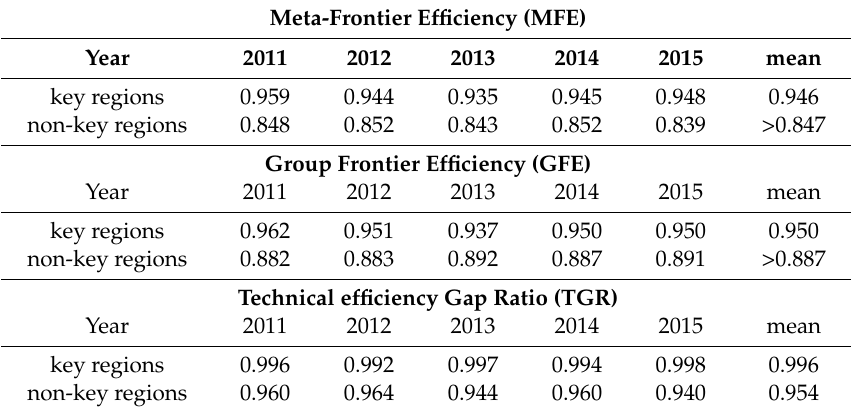
Table 3. of MFE, GFE, and TGR from 2011–2015.